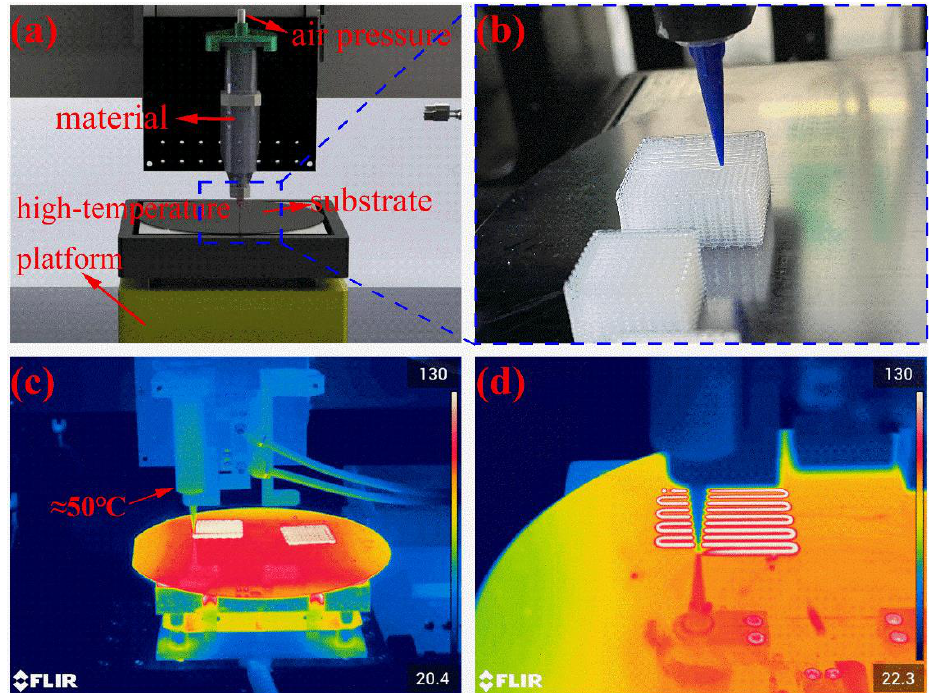
Figure 2. Heating-assisted direct writing 3D printing system: ( a ) overall view; ( b ) partial view; thermal imaging camera (E95, FLIR, Wilsonville, State of Oregon, USA) pictures of ( c ) overall view and ( d ) view of needle and sample.